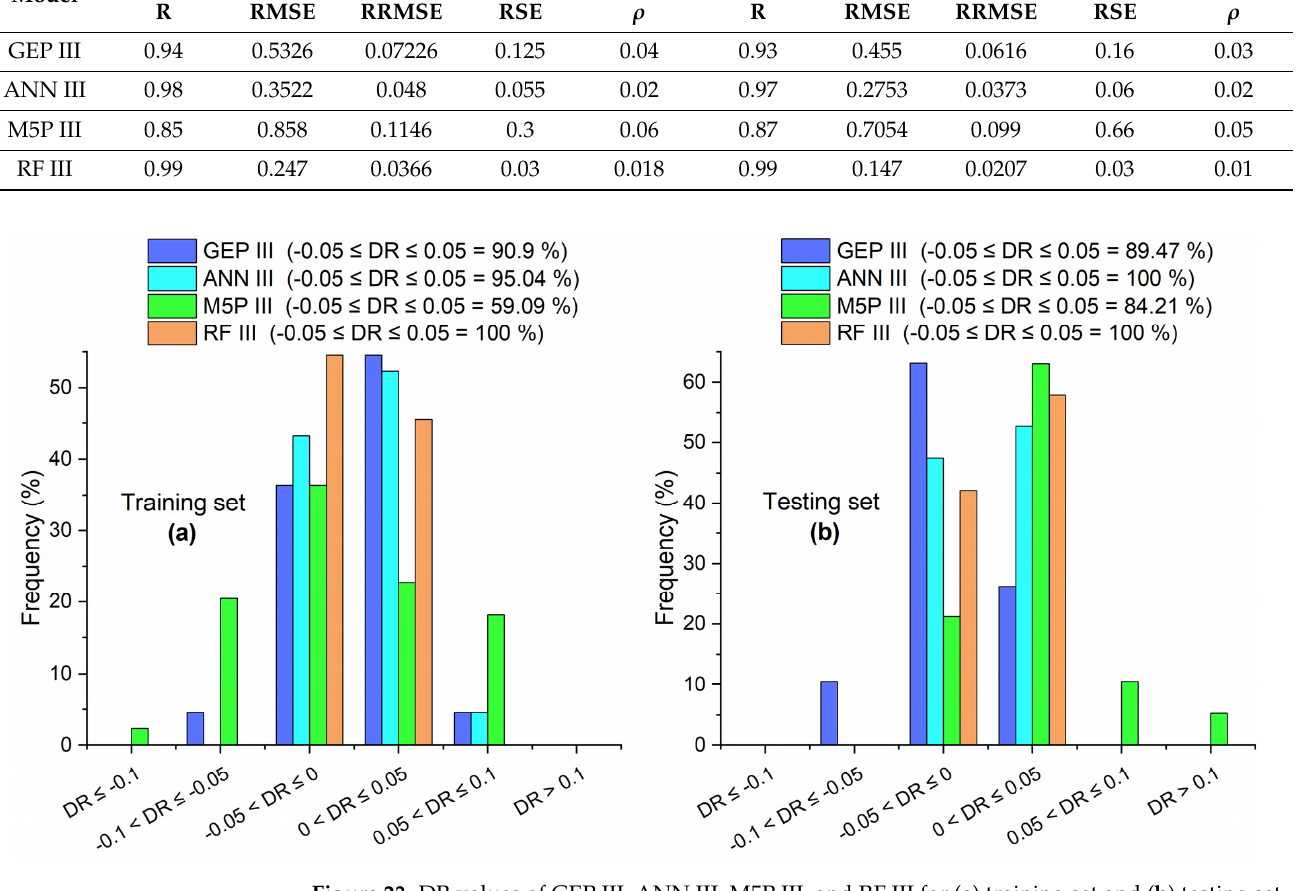
Figure 23. DR values of GEP III, ANN III, M5P III, and RF III for ( a ) training set and ( b ) testing set.